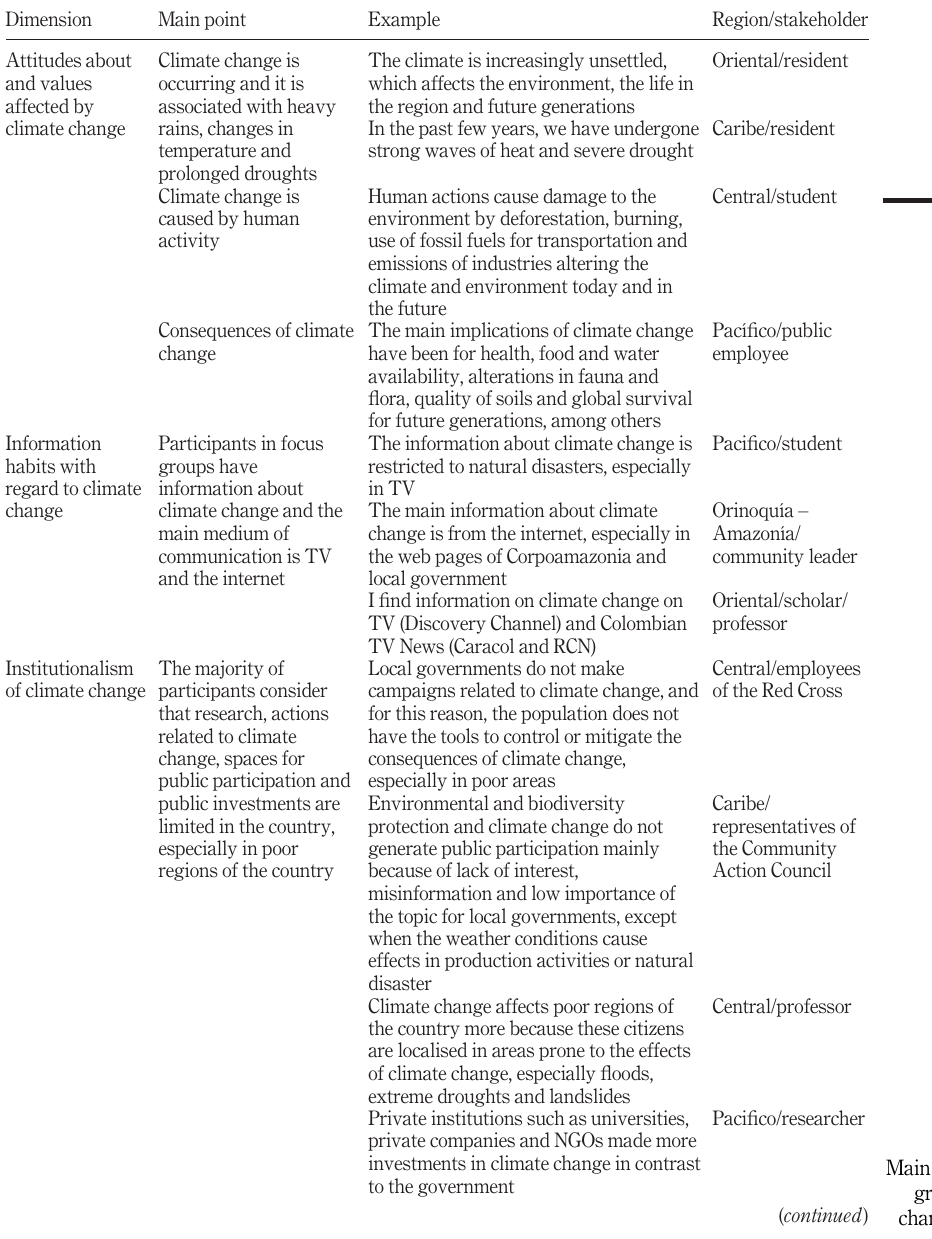
Table IV. Main results of